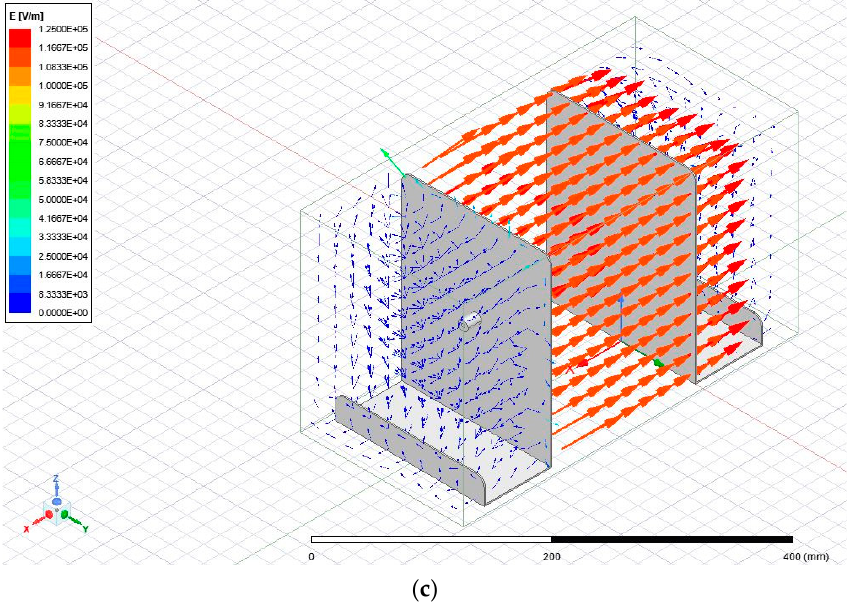
Figure 6. ( a ) Top-down view of electric field generated in parallel-plate configuration. ( b ) Side view of electric field generated in parallel-plate configuration. ( c ) Isometric view of electric field generated in parallel-plate configuration. Table 3. Electrospun fiber diameters and associated